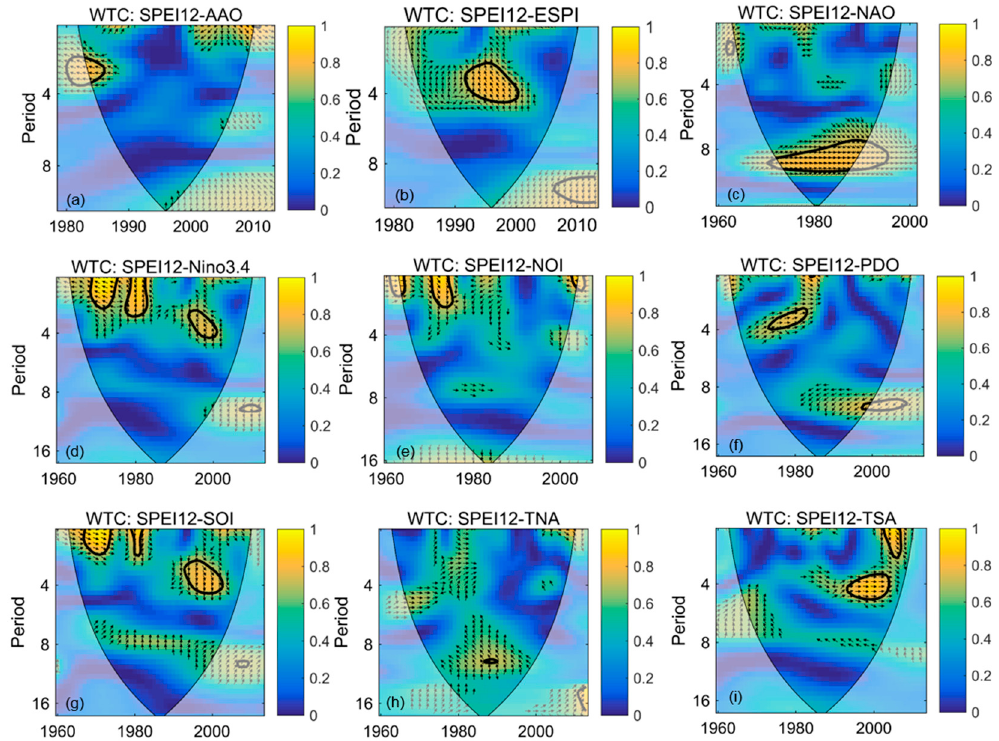
Figure 5. The results of Wavelet Transform Coherence (WTC) of SPEI (at 12-month scale) and the